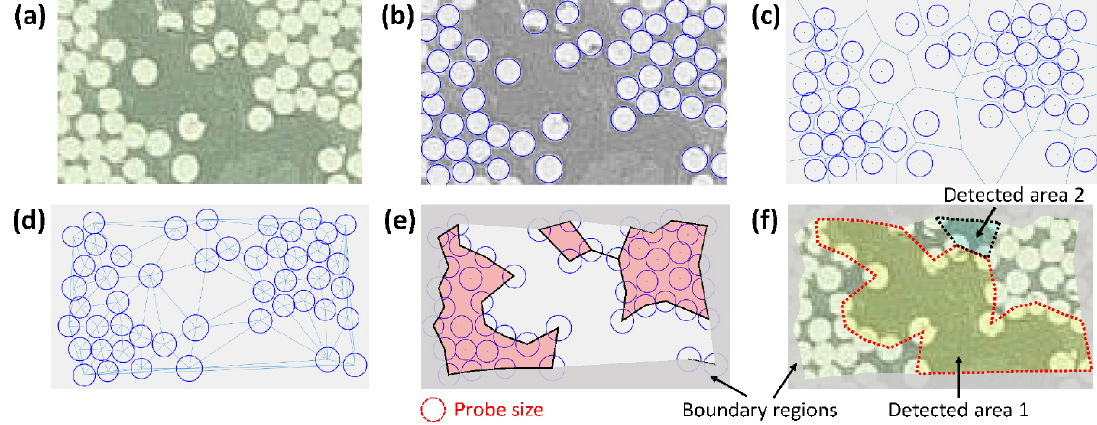
Fig. 4 Algorithm overview: (a) input microscope image, (b) circle detection, (c) Voronoi diagram, (d) dual triangulation, (e) α -shape in the refined region, (f) resulting fiber-deficient areas, the complement of the α -shape. The boundary region is the complement of the refined region, and is